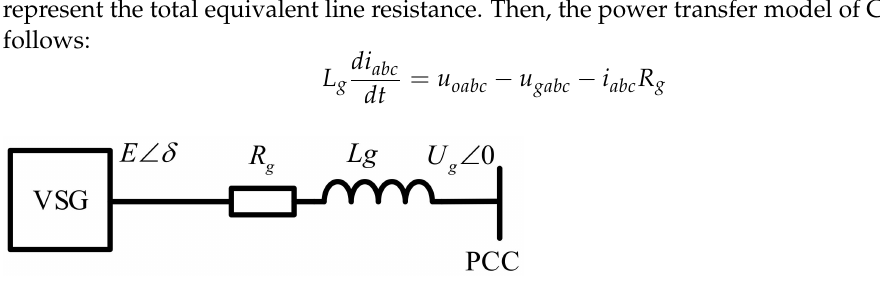
Figure 2. Equivalent power transmission